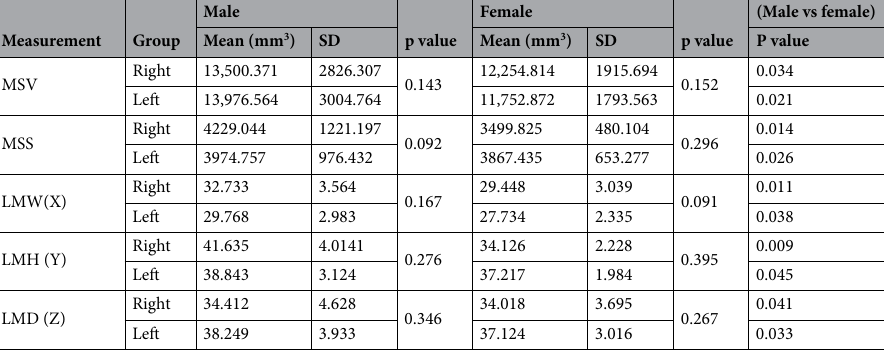
Table 2. Descriptive statistics for MS measurements; paired student T test between right and left side to assess symmetry. Independent t-test was used to compare male and female subjects. A p value < 0.05 was considered statistically significant.